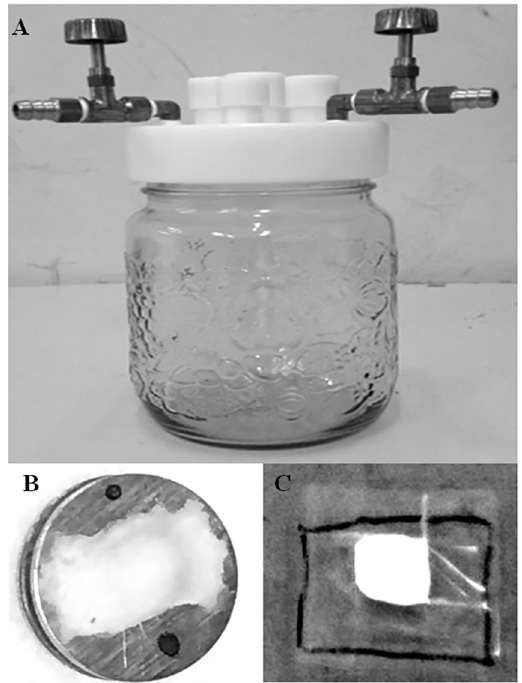
Figure 1. Synthesis of latex beads: (A) - cylindric flask; (B) - film coated at metallic substrate; (C) - film coated at glass